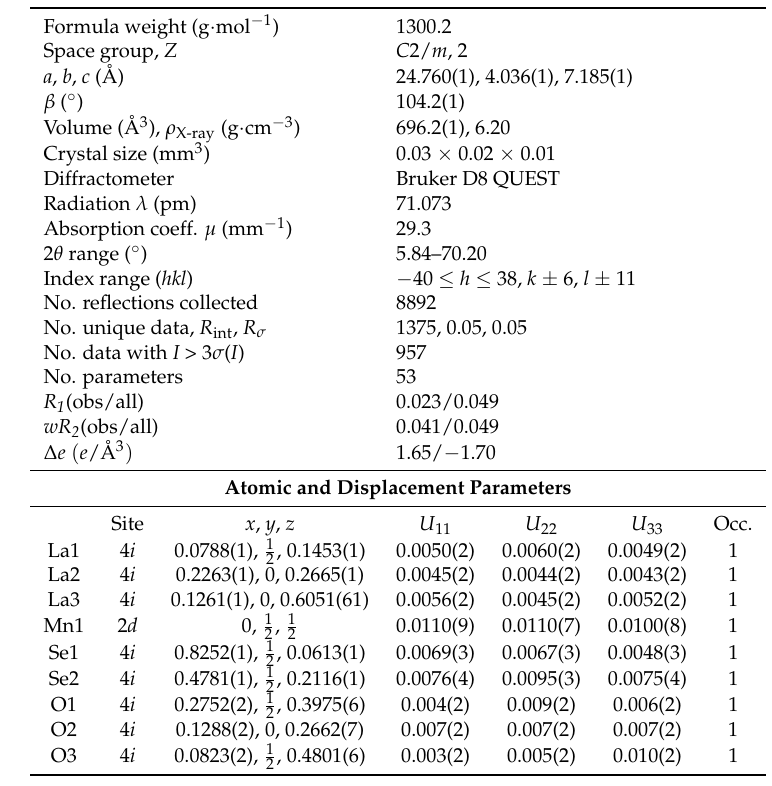
Table A3. Crystallographic data of La 6 MnSe 4 O 6